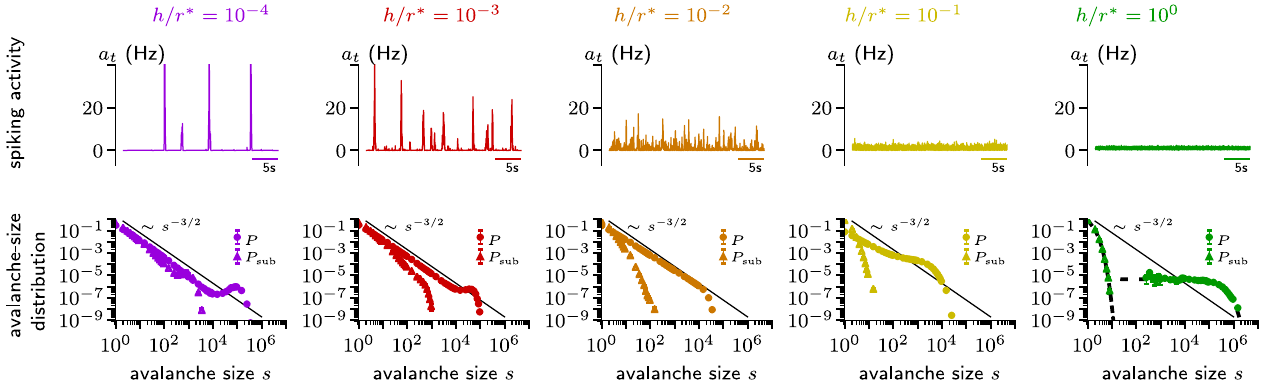
FIG. 3. Homeostatic plasticity induces diverse dynamic states by regulating recurrent network interactions, mediating input rate h and target neural firing rate r (cid:2) . The annealed-average network reproduces bursting ( m > 1 , h=r (cid:2) ≤ 10 − 3 , purple – red); fluctuating ( m ≈ 0 . 99 , h=r (cid:2) ≈ 10 − 2 and m ≈ 0 . 9 , h=r (cid:2) ≈ 10 − 1 , orange – yellow); and irregular ( m ≈ 0 , h=r (cid:2) ¼ 1 , green) dynamics. The top row shows examplary spiking activity a t ¼ A t =N Δ t (Appendix B-1); the bottom row shows avalanche-size distributions P ð s Þ ( n ¼ N , circles) and s Þ ( n ¼ 100 , triangles) averaged over 12 independent simulations (Appendix B-2). Solid subsampled avalanche-size distributions P sub ð lines show the power-law distribution P ð s Þ ∝ s − 3 = 2 [77], and dashed lines show the analytical avalanche-size distribution of a Poisson 10 3 s, r (cid:2) ¼ 1 Hz, Δ t ¼ 1 process [92]. The parameters are N ¼ 10 4 , τ hp ¼